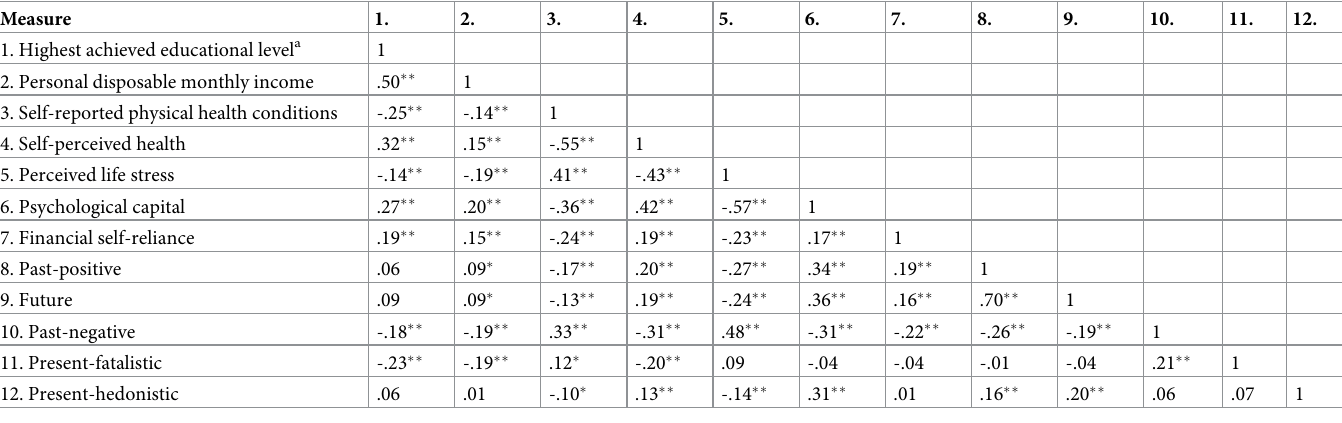
Table 1. Pearson and Spearman’s rho correlations between model